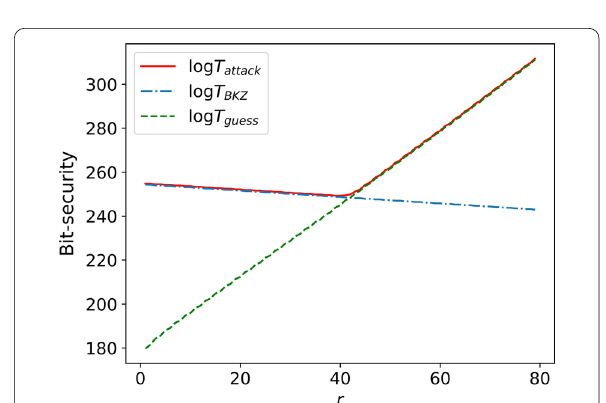
Fig. 2 Example: T Hybrid1 , T BKZ and T guess for